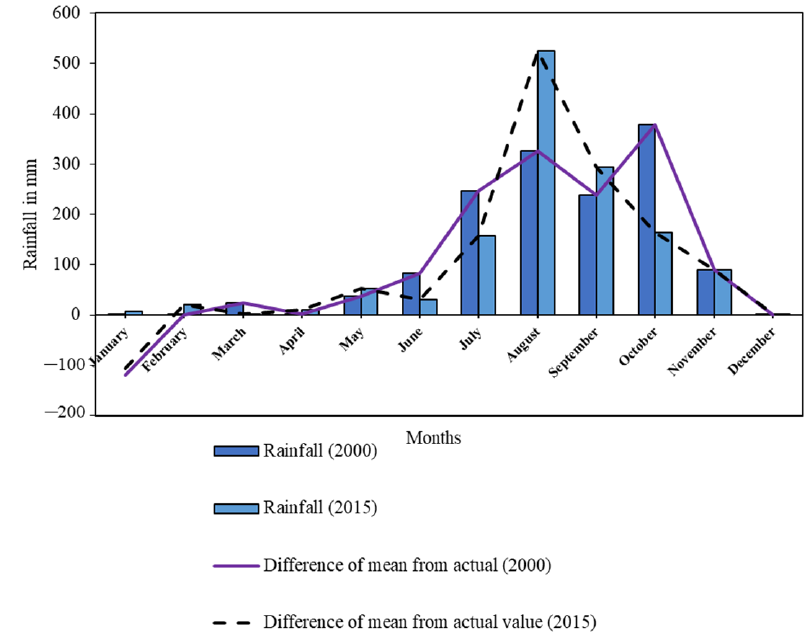
Figure 3. Annual rainfall situation of 2000 and 2015.